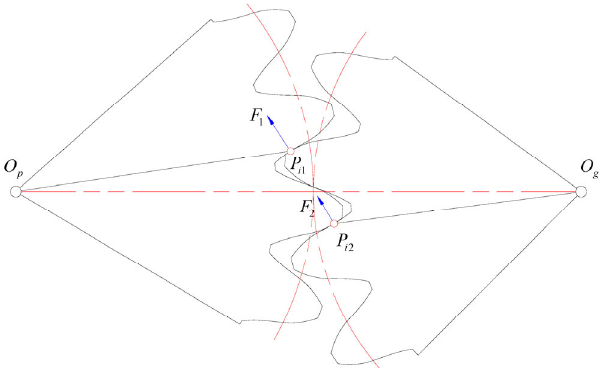
Fig. 4 Modification of tooth profile for the basic